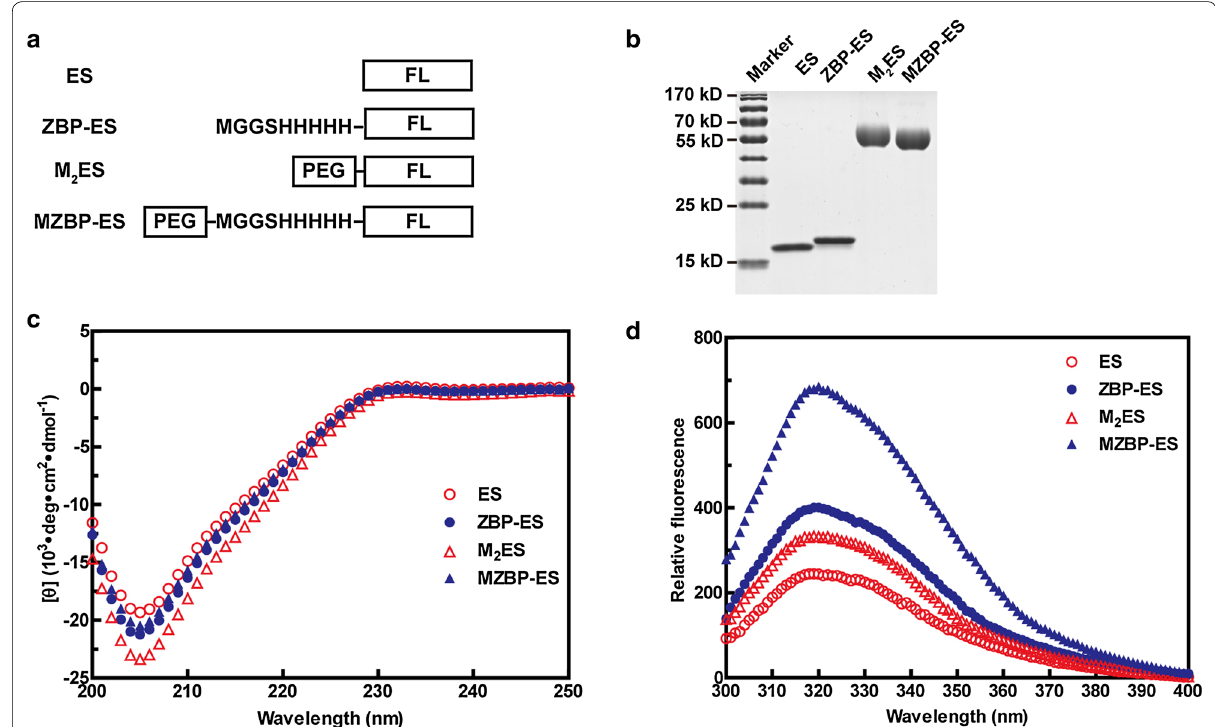
Fig. 1 Sequence, purification, and structural analyses of endostatin ( ES ) variants. a Sequences of ES, zinc-binding protein-ES ( ZBP-ES ), mono- PEGylated ES ( M 2 ES ), and mono-PEGylated ZBP-ES ( MZBP-ES ). FL full length. b The purity of ES and its variants examined by sodium dodecyl sulfate– polyacrylamide gel electrophoresis ( SDS – PAGE ). c Secondary structures of ES and its variants detected by far-ultraviolet circular dichroism (far-UV CD) spectra. d Tertiary structures of ES and its variants tested with tryptophan emission